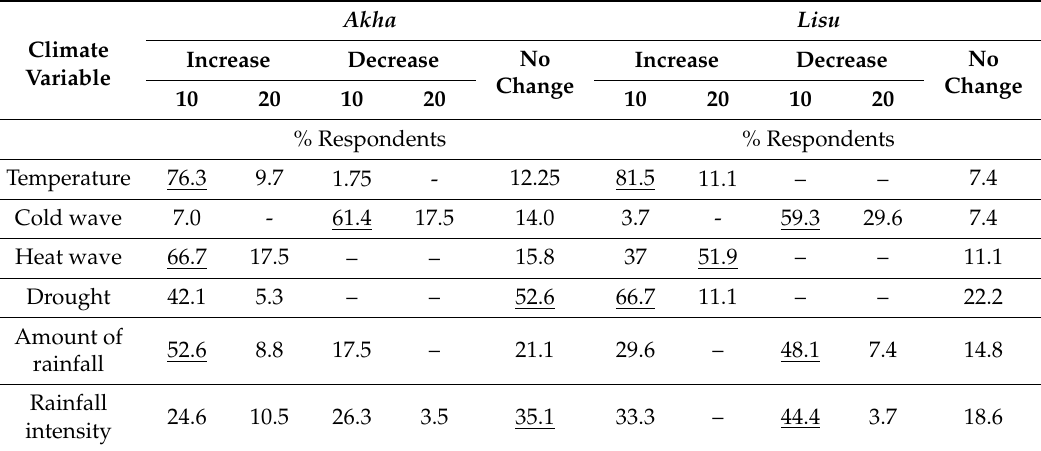
Table 3. Perceived trend of climate by